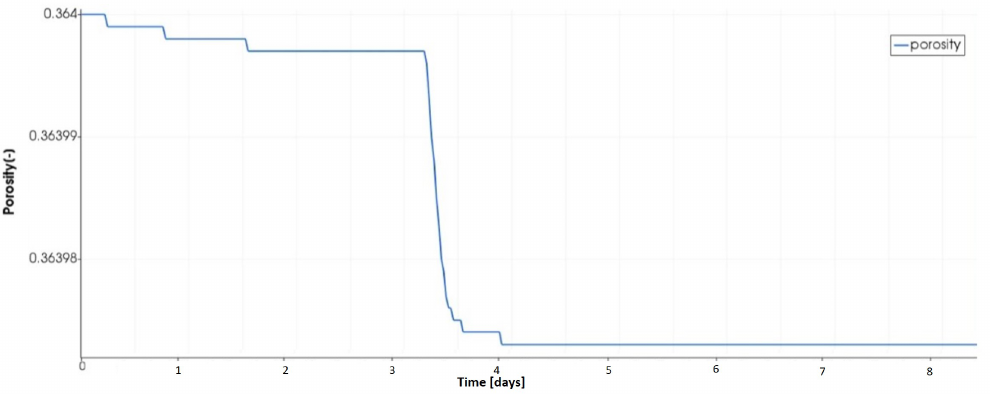
Figure 14. Evolution of the initial porosity at the top of the porous medium.